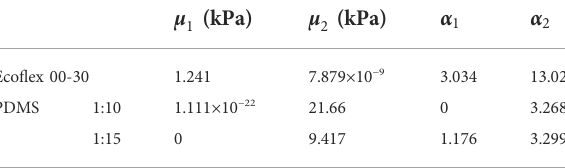
TABLE 1 Two-term Ogden parameters of Eco fl ex 00-30, and PDMS with 1:10, 1:15 ratio of base to curing